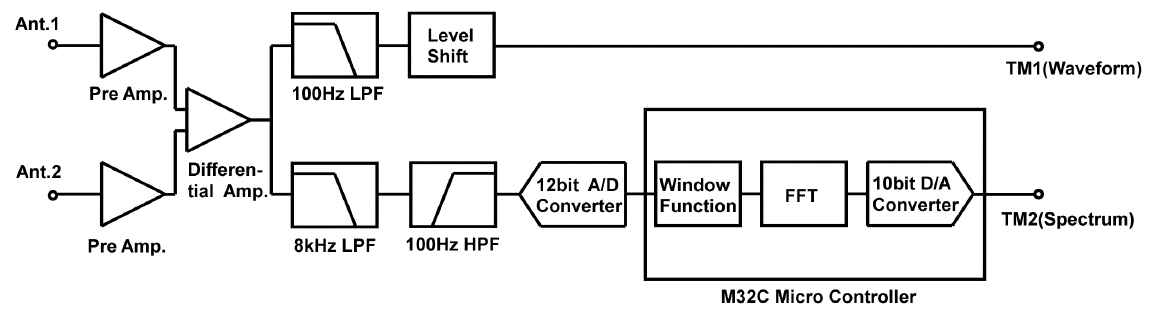
Fig. 2. The block diagram of PWM. The left side is the BeCu (Beryllium-Copper) dipole antenna, and the detected wave is subtracted by